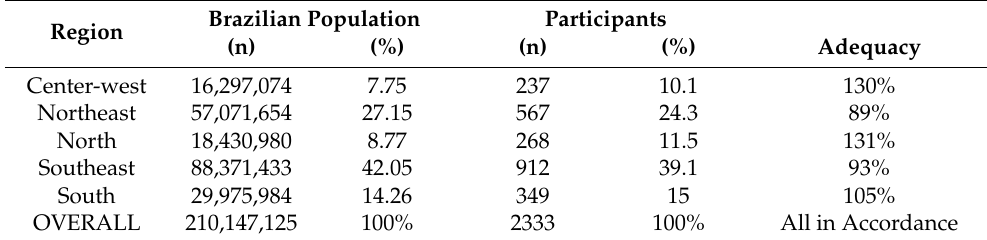
Table 1. National distribution of